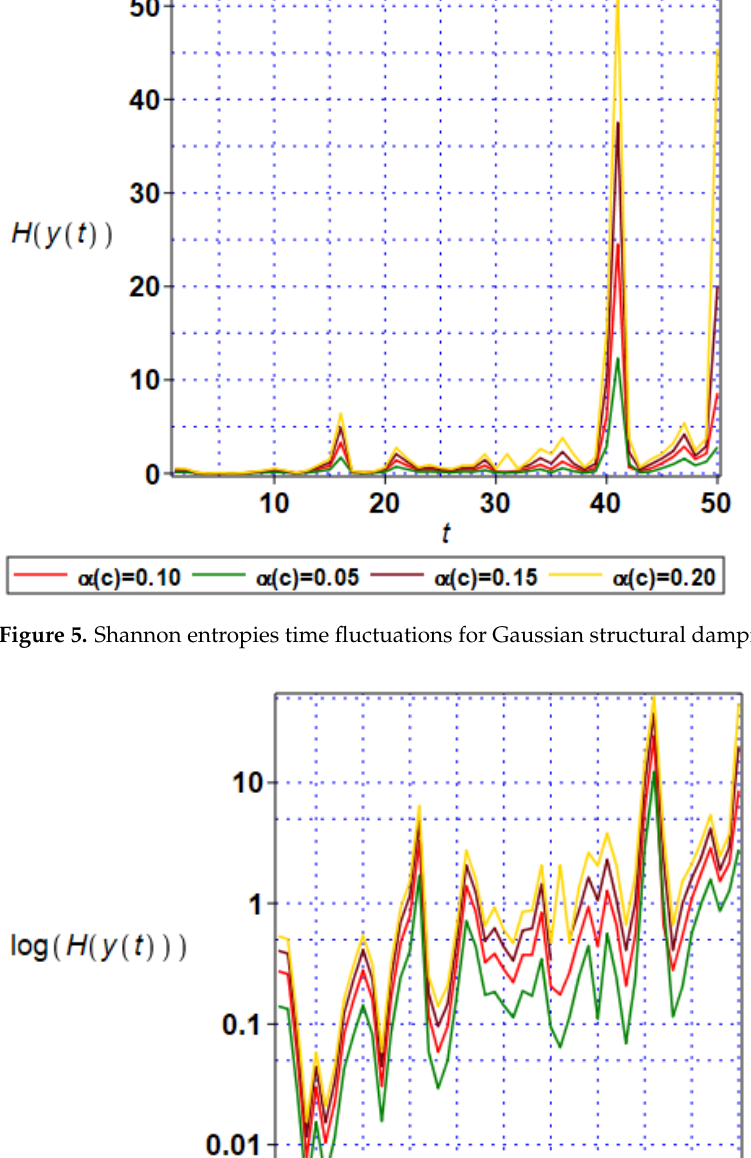
Figure 7. Shannon entropies time fluctuations for uniformly distributed structural damping.